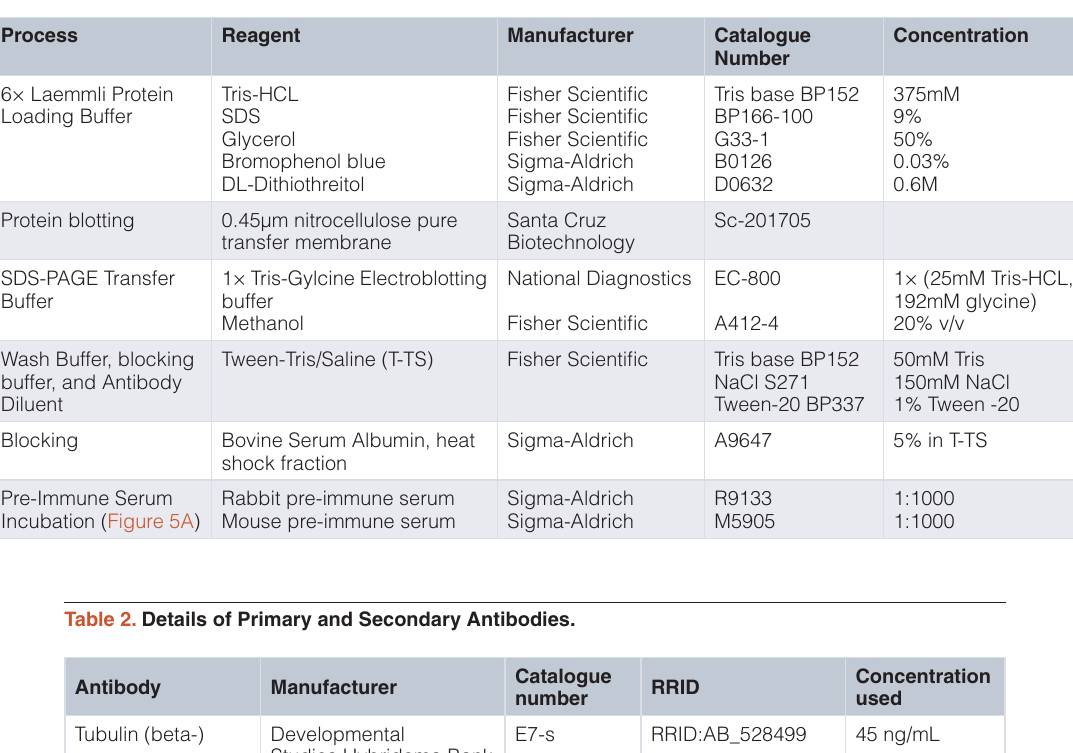
Table 1. Details of reagents used for immunoblotting.